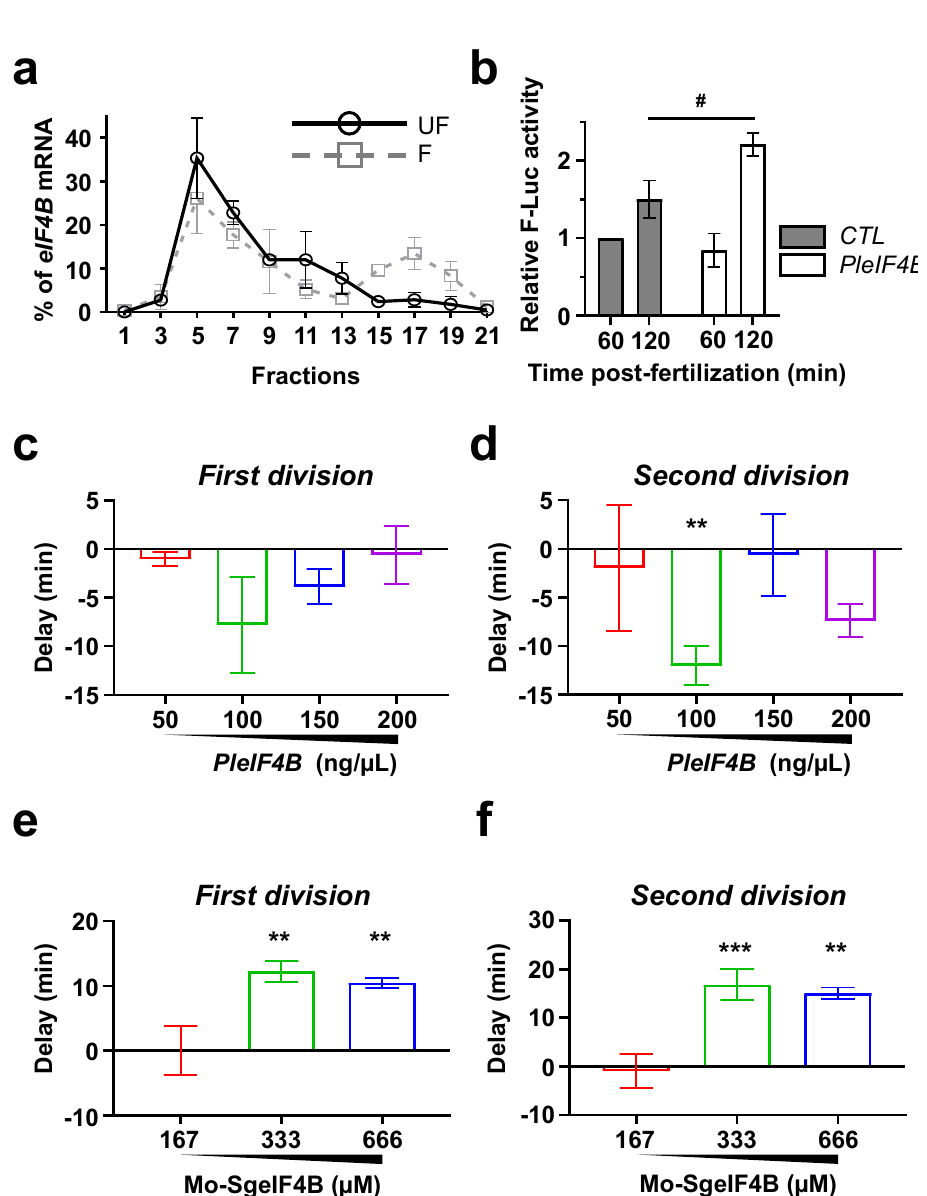
Figure 5. The effects of eIF4B mRNA on translation and cell cycle dynamics are conserved in S. granularis . ( a ) eIF4B mRNA is recruited into polysomes following fertilization. eIF4B mRNA was measured by RT-qPCR in each fraction from unfertilized eggs (UF) and 90 min post-fertilization (F). Distribution is shown along the gradient as a percentage of total mRNA. Fraction #1 corresponds to the top of the gradient (free mRNAs), and #21 corresponds to the bottom of the gradient (polysomal fractions). Error bars represent the SEM of two experiments done with independent females. ( b ) eIF4B mRNA microinjection stimulates the in vivo mRNA translation activity in S. granularis fertilized eggs. F-Luc mRNA (100 ng/ µ L) was introduced by microinjection into the eggs in the presence of either P. lividus eIF4B mRNA (100 ng/ µ L) or CTL mRNA (100 ng/ µ L). Firefly luciferase luminescence was normalized to the CTL mRNA condition at 60 min post-fertilization. Error bars represent SEM for experiments performed in triplicate in three independent females. Thirty eggs were microinjected for each condition. (Multiple- t -test: # p -value < 0.05). ( c , d ) Microinjection of eIF4B mRNA accelerates the dynamics of the two first cell divisions in S. granularis early embryos. Time for fifty percent of first cleavage ( c ) or second cleavage ( d ) was assessed under a light microscope after microinjection of indicated P. lividus eIF4B mRNA concentration. In each experiment, constant total mRNA concentration (250 ng/ µ L) was microinjected by adding the required Firefly luciferase mRNA to the microinjection solution. One hundred eggs were microinjected, fertilized and monitored for cell division for each condition. Error bars represent the SEM of three independent overexpression